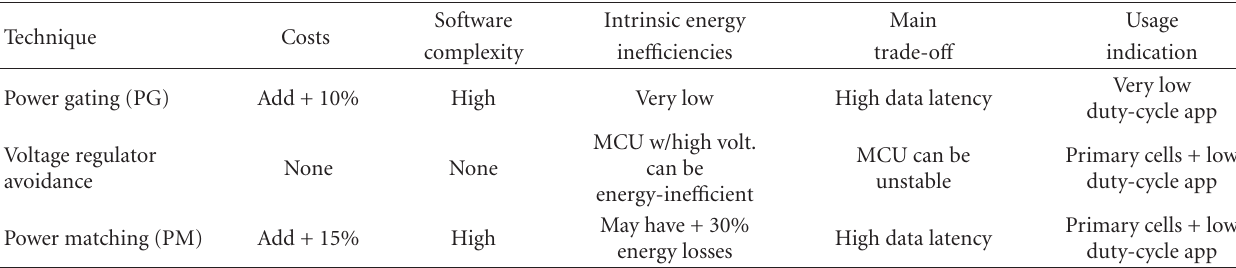
Table 2: Overview of the proposed power management techniques.